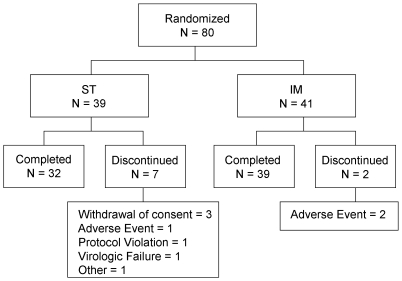
Patient Disposition.
* ST: Standard Treatment; IM: Induction/Maintenance.